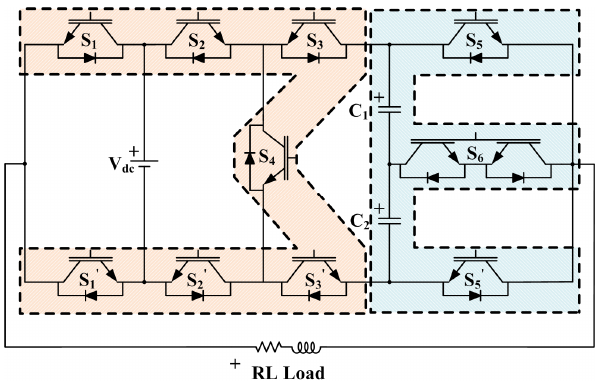
Figure 1. Circuit diagram of WE topology.